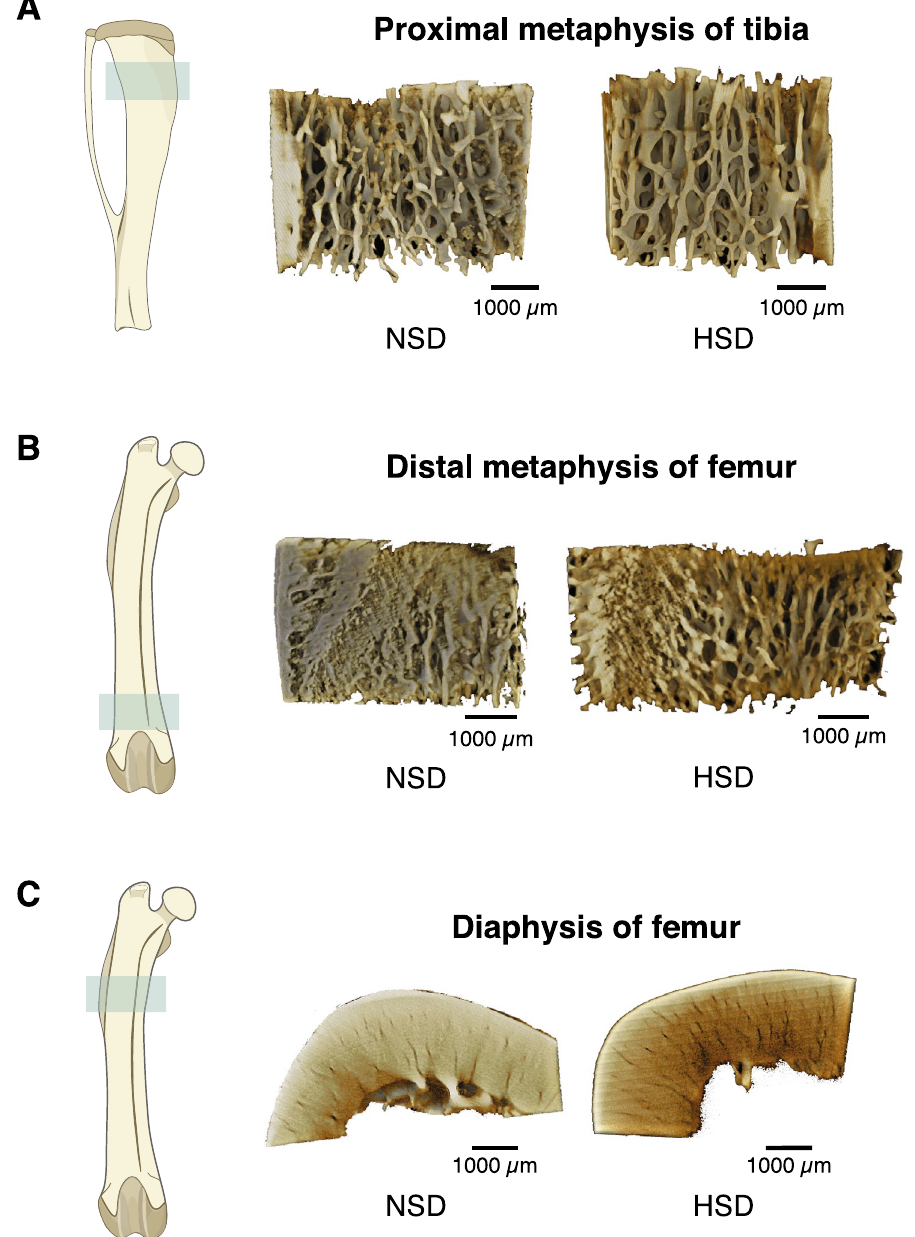
Figure 4. The representative images of bone specimens and their microstructures obtained from SRXTM, scale bar: 1000 µm. ( A ) Longitudinal section trabecular bone at proximal metaphysis of tibiae, ( B ) trabecular bone at distal metaphysis of femurs and ( C ) cross-sectional cortical bone at diaphysis of femurs in NSD and